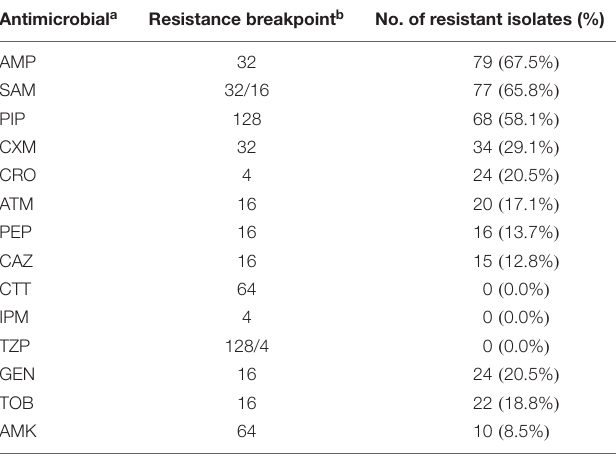
TABLE 1 | Antimicrobial resistance of 117 Salmonella isolates recovered from retail meat. Antimicrobial a Resistance breakpoint